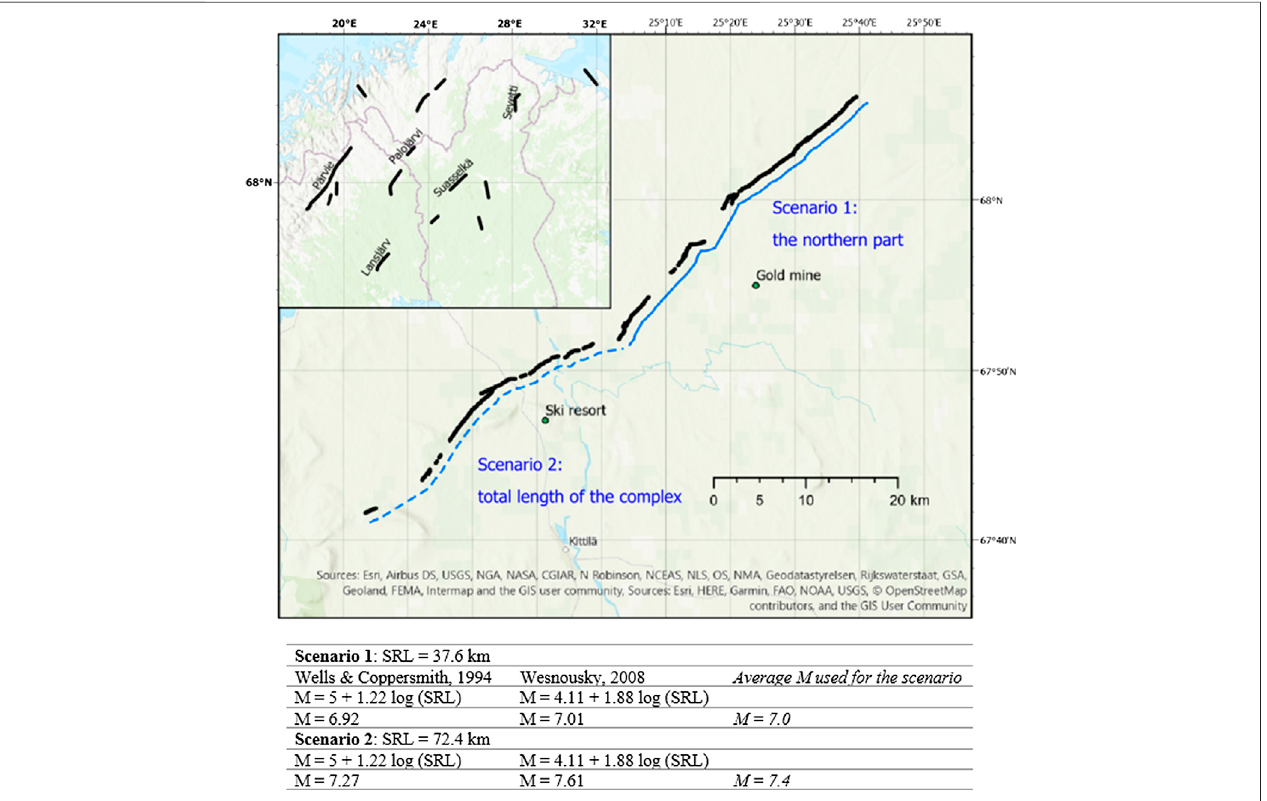
FIGURE 12 | Suasselkä post-glacial fault as mapped by Ojala et al. (2019a, 2019b). SE block is the upthrown side. The northern section (Scenario 1) consists of Suaspalo, Suasoja and Nilimaa systems, the expected surface rupture length (SRL) for an earthquake rupturing the entire northern section is 37.6 km. The length of the entire Suasselkä post-glacial fault complex is 72.4 km (Scenario